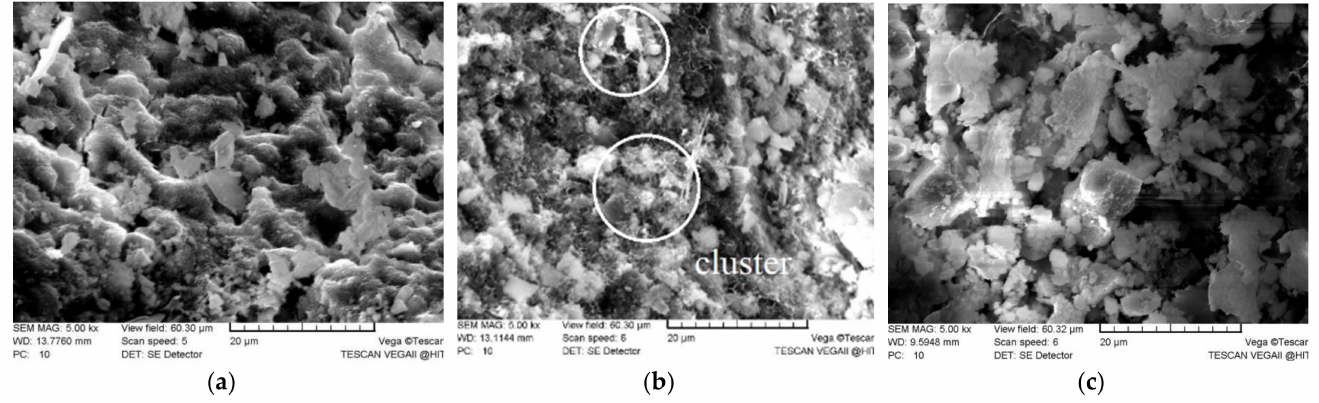
Figure 6. SEM images of graphene concrete in different temperatures: ( a ) 29, ( b ) 37, and ( c ) 45 ◦